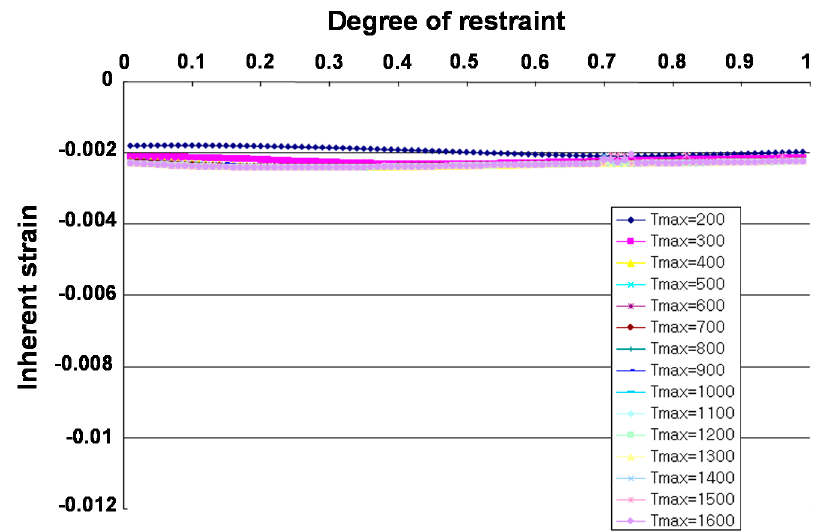
Figure 5. Inherent strain chart: fillet welding ( x -direction).